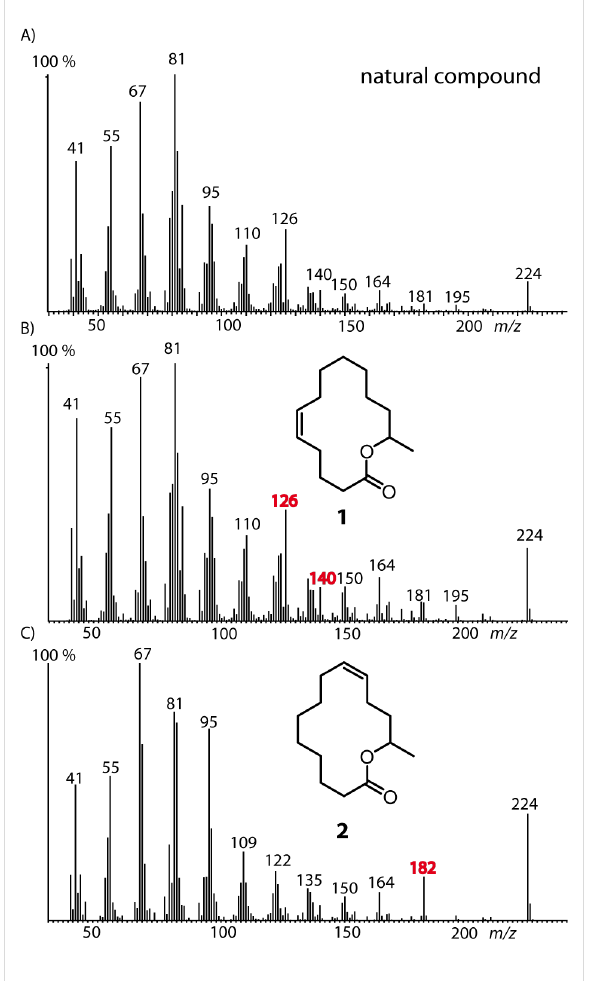
Figure 3: Mass spectra of A) the natural compound A , B) ( Z )-tetradec- 5-en-13-olide ( 1 ), and C) ( Z ) - tetradec-9-en-13-olide ( 2 ). Characteristic ions useful for location of the double bond are marked in